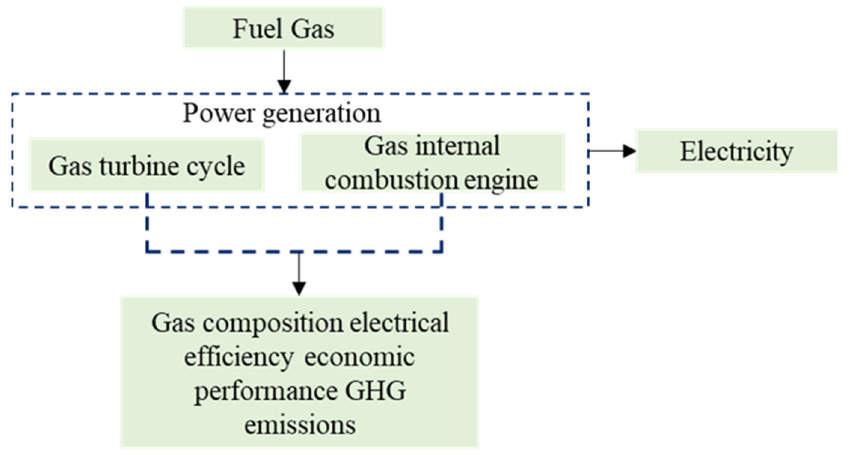
Figure 2. Power generation scenarios.